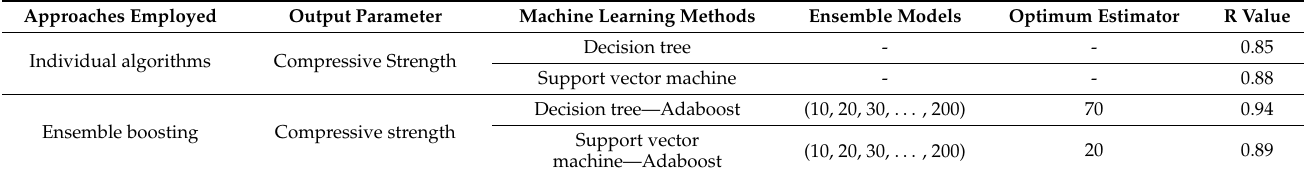
Table 5. R 2 values of individual and ensemble